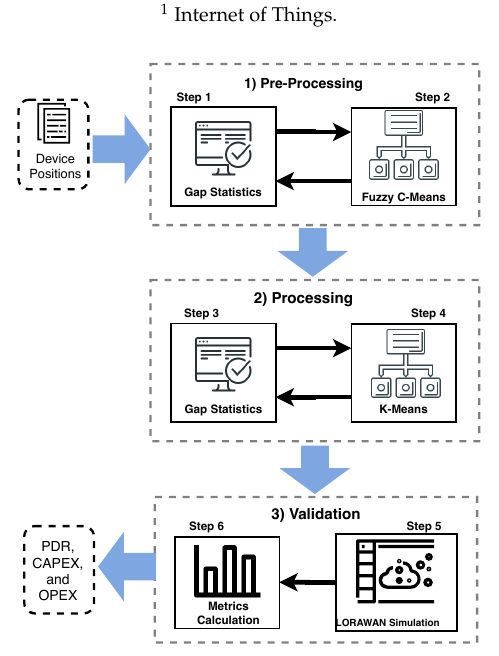
Figure 1. DPLACE